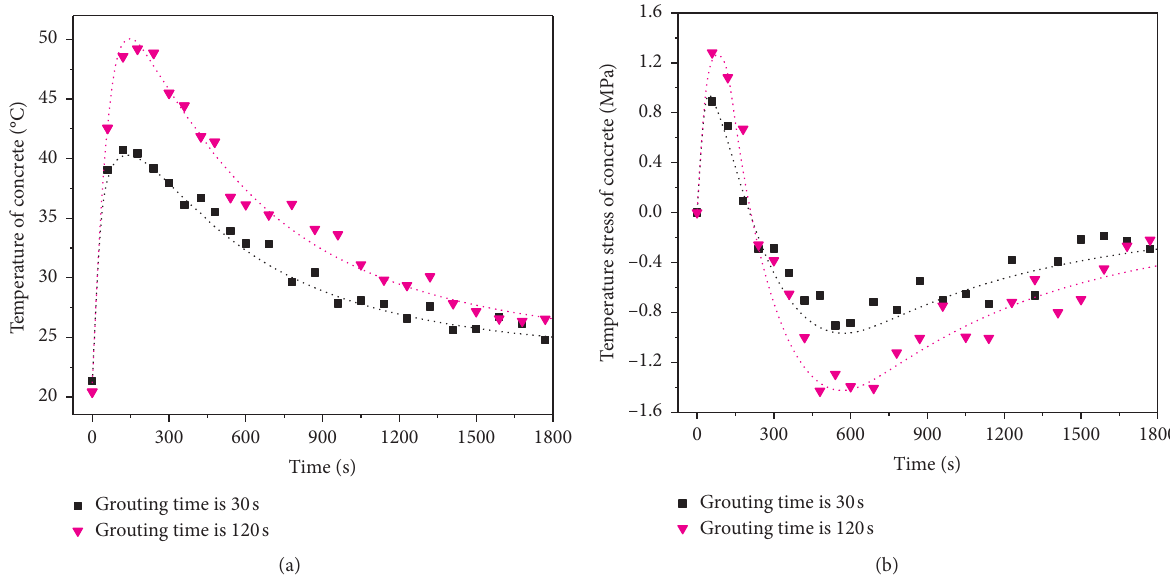
Figure 9: Comparison of the temperature and the temperature stress in the concrete at different grouting time. (a) Temperature. (b) Temperature